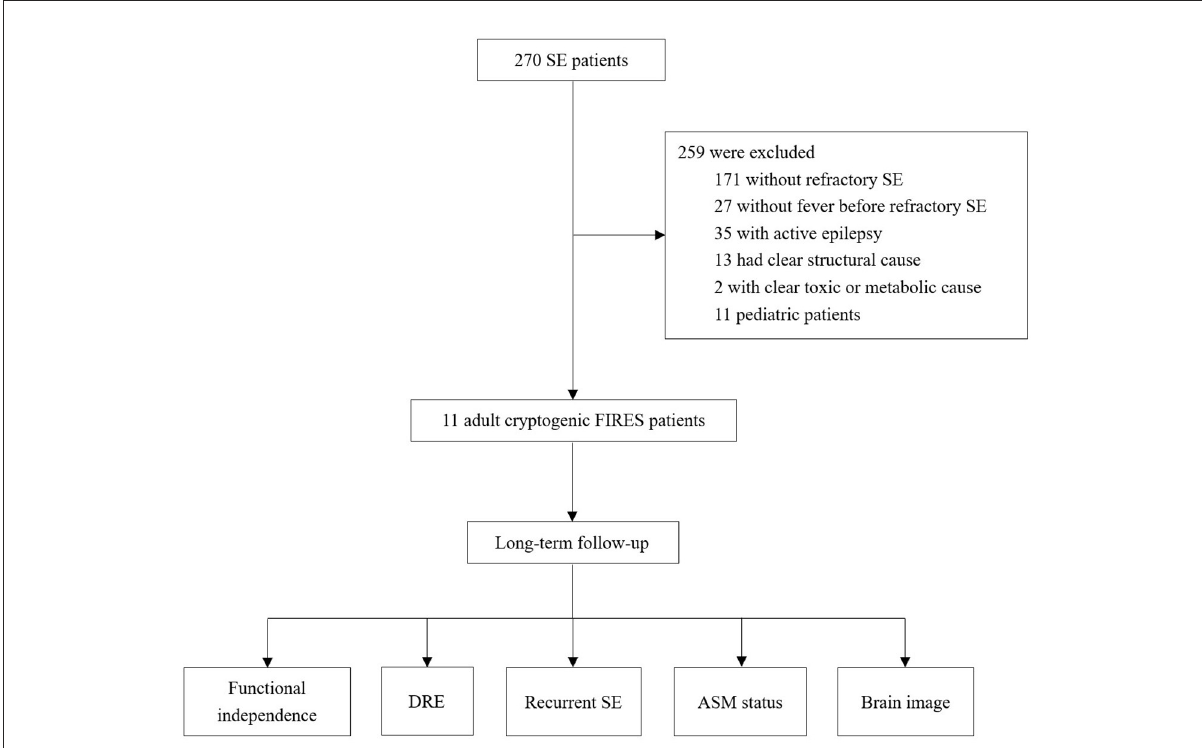
FIGURE1 Flowchart of the study. SE, status epilepticus; FIRES, febrile infection-related epilepsy syndrome; DRE, drug-resistant epilepsy; AEM, anti-seizure